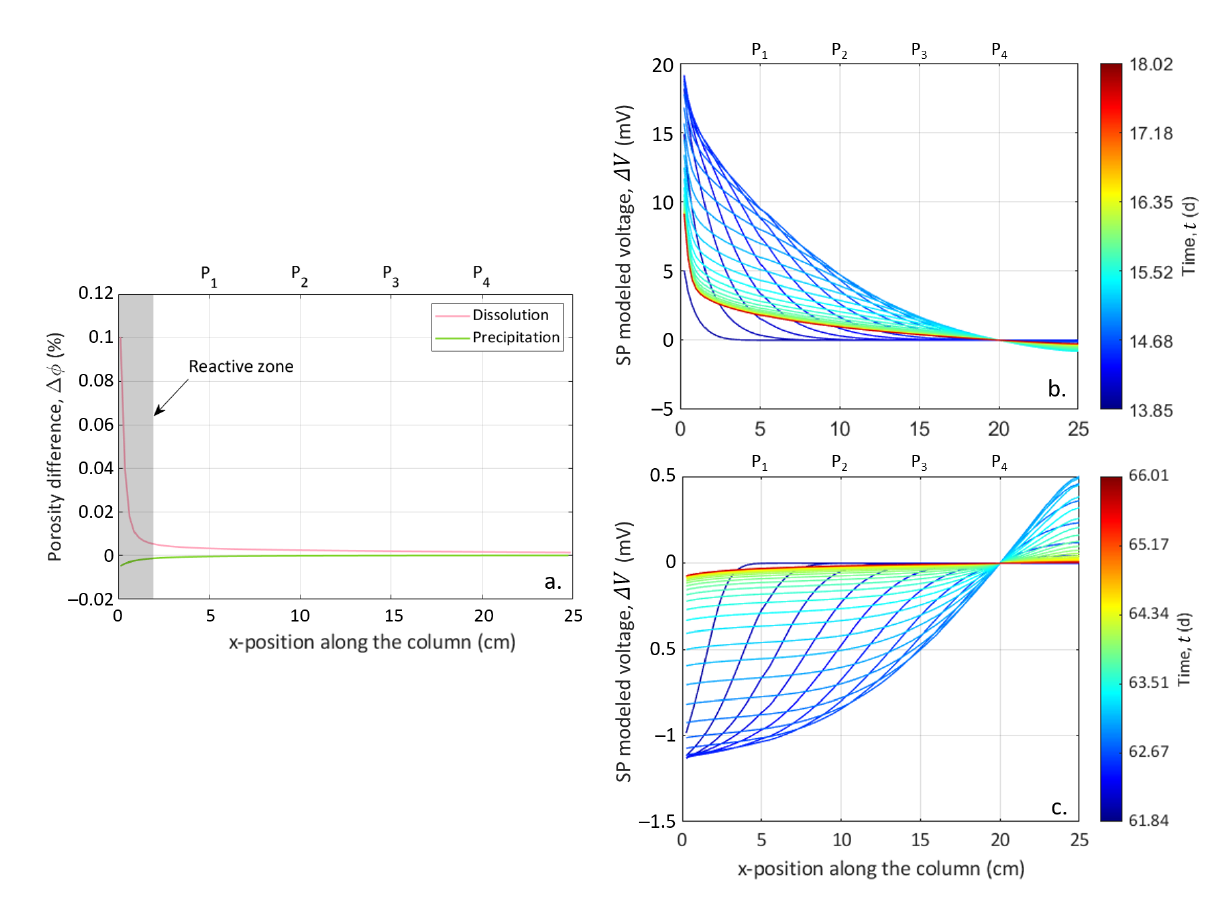
Figure 9. Representations along the column. Locations of measurement electrodes P 1 , P 2 , P 3 , and P 4 are indicated on top of each graphic. ( a ) Porosity difference along the column for CrunchFlow simulations of calcite dissolution and precipitation. ( b ) The SP voltage is modeled at different time steps during calcite dissolution. ( c ) The SP voltage is modeled at different time steps during calcite